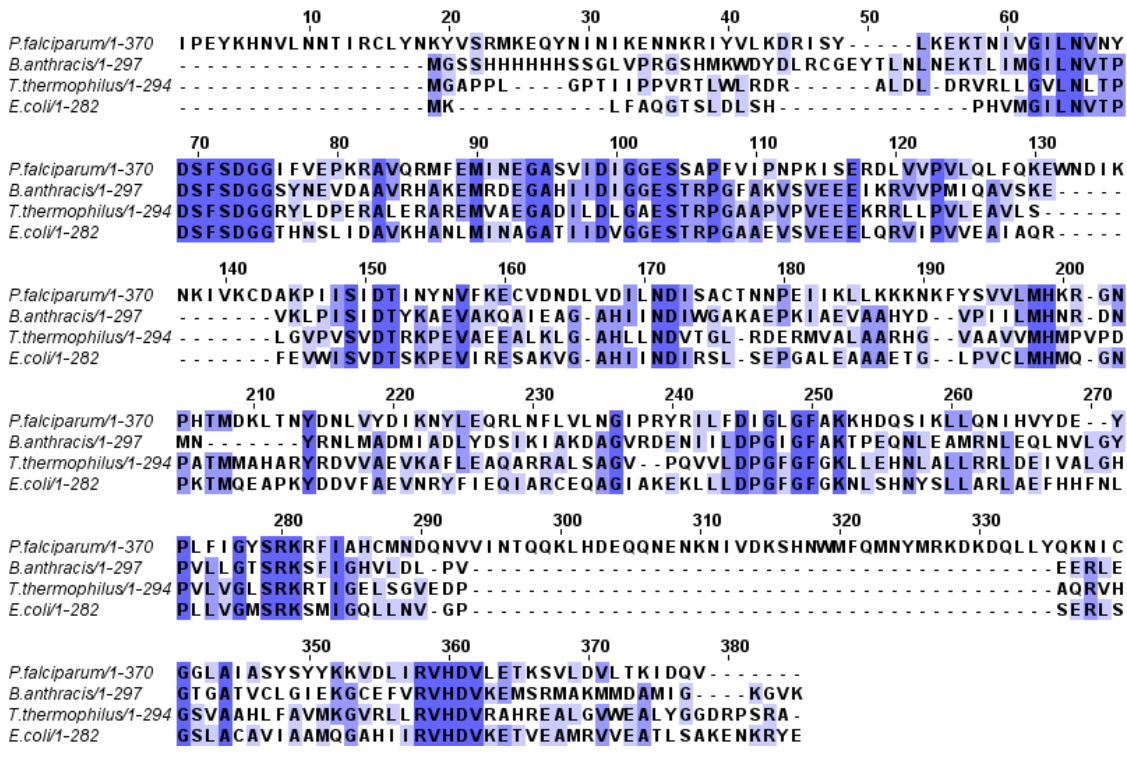
Figure 1. Multiple sequence alignment of the malarial enzyme and the top-3 similar sequences.